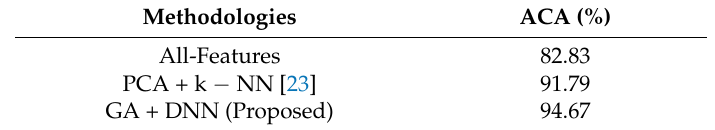
Table 4. Average classification of the three different models.